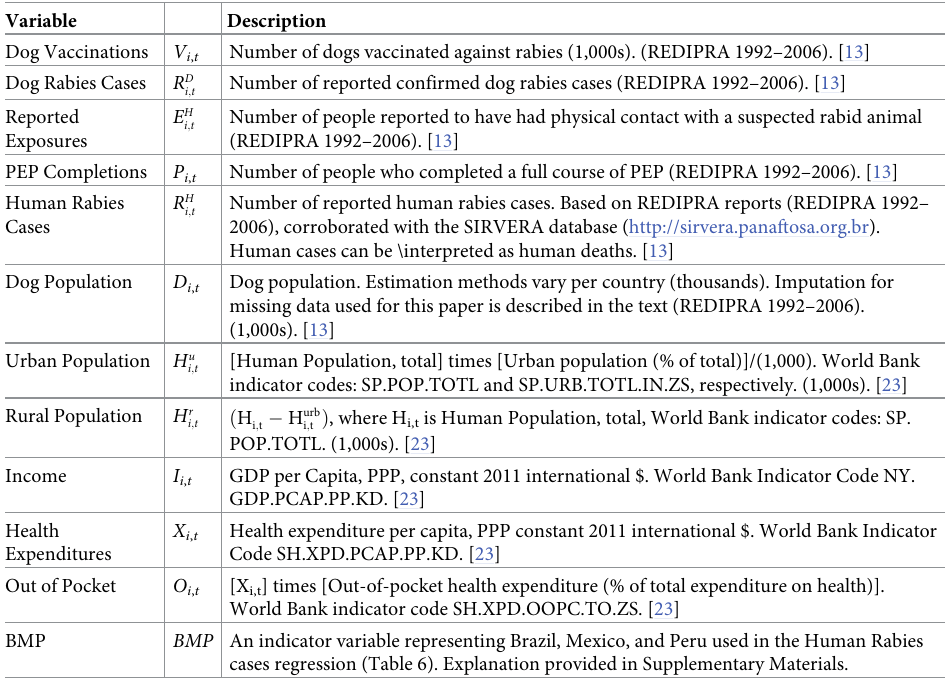
Table 1. Data descriptions of variables used in analysis.